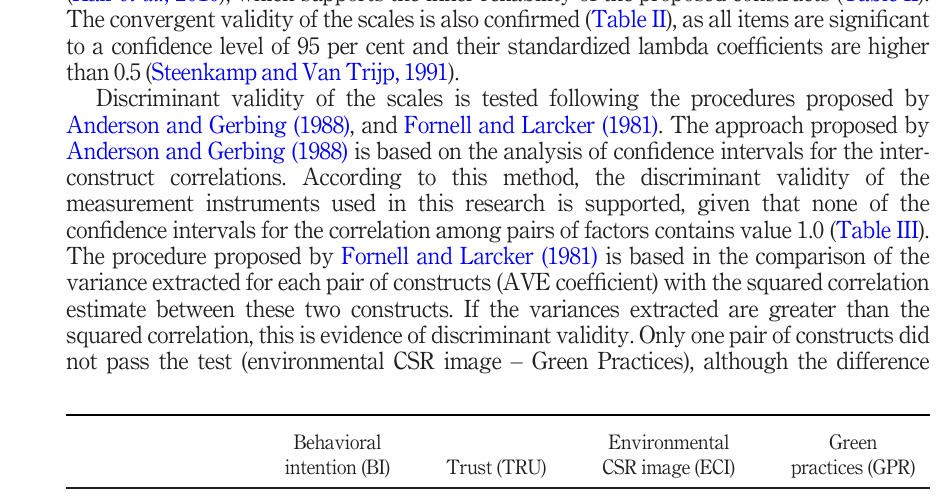
Table III. Con fi dence intervals for the correlation among pairs of factors